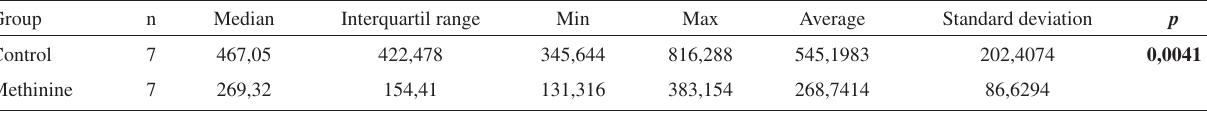
Table 1 - Intimal thickening statistical analysis